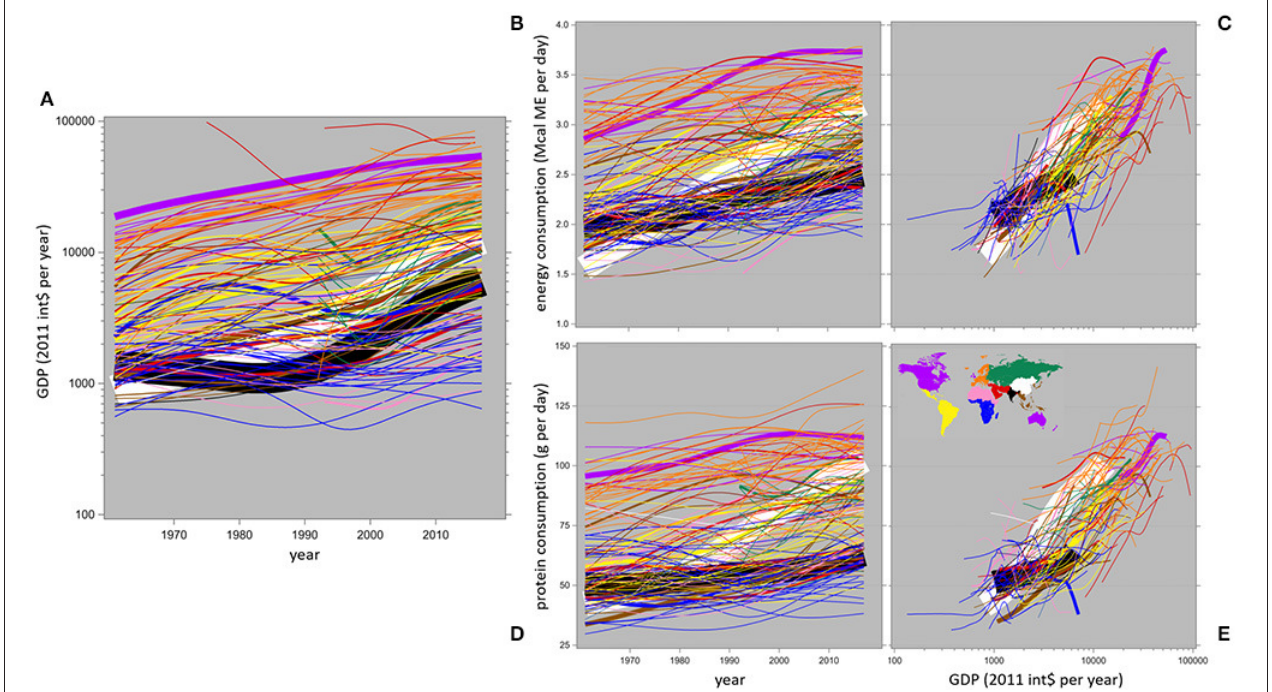
FIGURE 1 | Country-specific spline interpolation plots (estimated by SAS-procedure TRANSREG with a smoothing factor sm = 60) of inflation-adjusted income in relation to time (A) , of energy and protein consumption in relation to time (B,D) , and of energy and protein consumption in relation to income unadjusted for other factors (C,E) . The width of each line reflects the country’s population size in 2016. Note that the income axes are